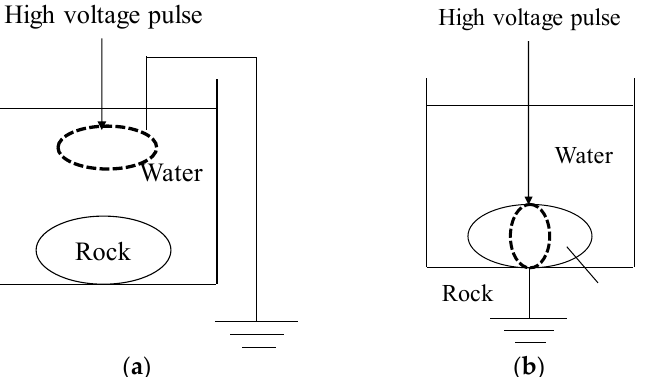
Figure 1. Model diagrams of different electric pulse crushing [4]. ( a ) EHD method; ( b ) ED method.